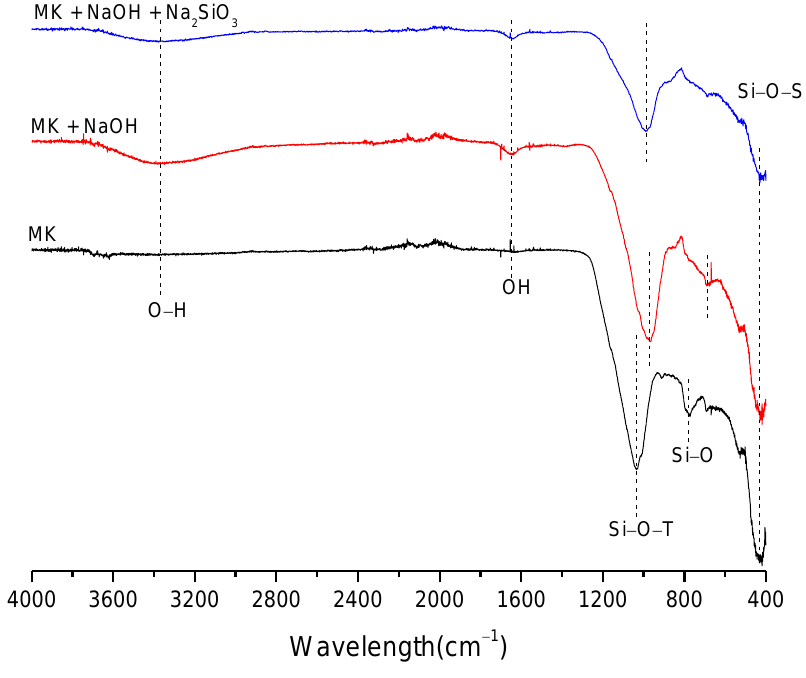
Figure 6. MK and MK activated pastes. The band assigned to the Si-O bond, which is larger in the precursor, is attributed to 800 cm − 1 wavenumber and exhibits a reduction of its intensity through alkaline activation. This change occurs due to the dissolution of precursors and the reorganization of silicon bonds. In addition, there is a reduction of the band near 400 cm − 1 associated with the Si-O-Si bond which could indicate structural changes in the silicon bond. FTIR spectrum of MK activated pastes is quite similar, except by intensity and wavenum- ber of a characteristic band of Si-O-T bond. The band is stronger for sodium hydroxide activation and exhibits lower values for sodium silicate activated paste. The lower wavenum- ber value is associated with the aluminum presence in paste structure which favors the formation of many crosslink bonds on products resulting from geopolymerization. Figure 7 shows the FTIR spectrum of SCBAM and SCBAMH activated pastes. In the SCBAMH pastes, only the paste activated with sodium hydroxide exhibits the hydrated products, however, the bands associated with these products are not significant. In addition, the bands assigned to C-O-C, Si-O-T, Si-O, and Si-O-Si bonds exhibit similar behavior to MK. However, at the FTIR spectrum of the pure precursor, it is possible to observe a band around 700 cm − 1 associated with the Al-O bond which decreases the intensity after activation due to the precursor dissolution